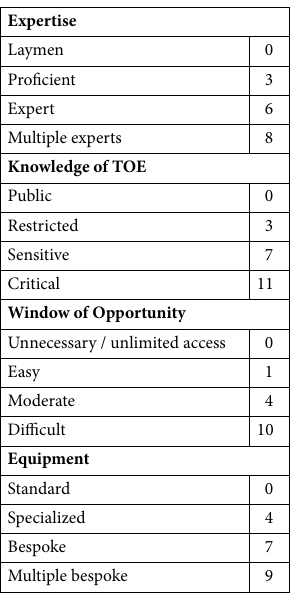
Table 3. Table for the evaluation of the Attack Potential used in the article. Elapsed time factor has not been considered: see text for explanations. For a complete guide on how evaluate those factors refer to the Common Evaluation Methodology version 3.1 25